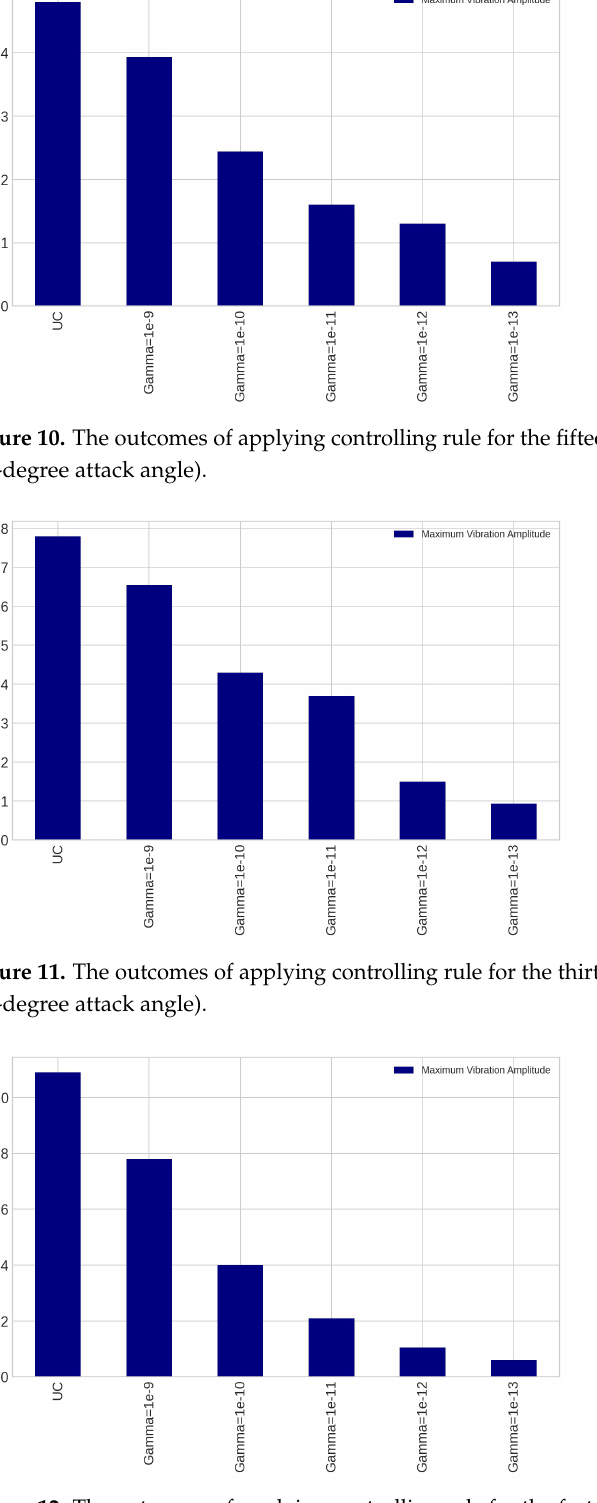
Figure 12. The outcomes of applying controlling rule for the forty-fifth sensor under loading number 2 (30-degree attack